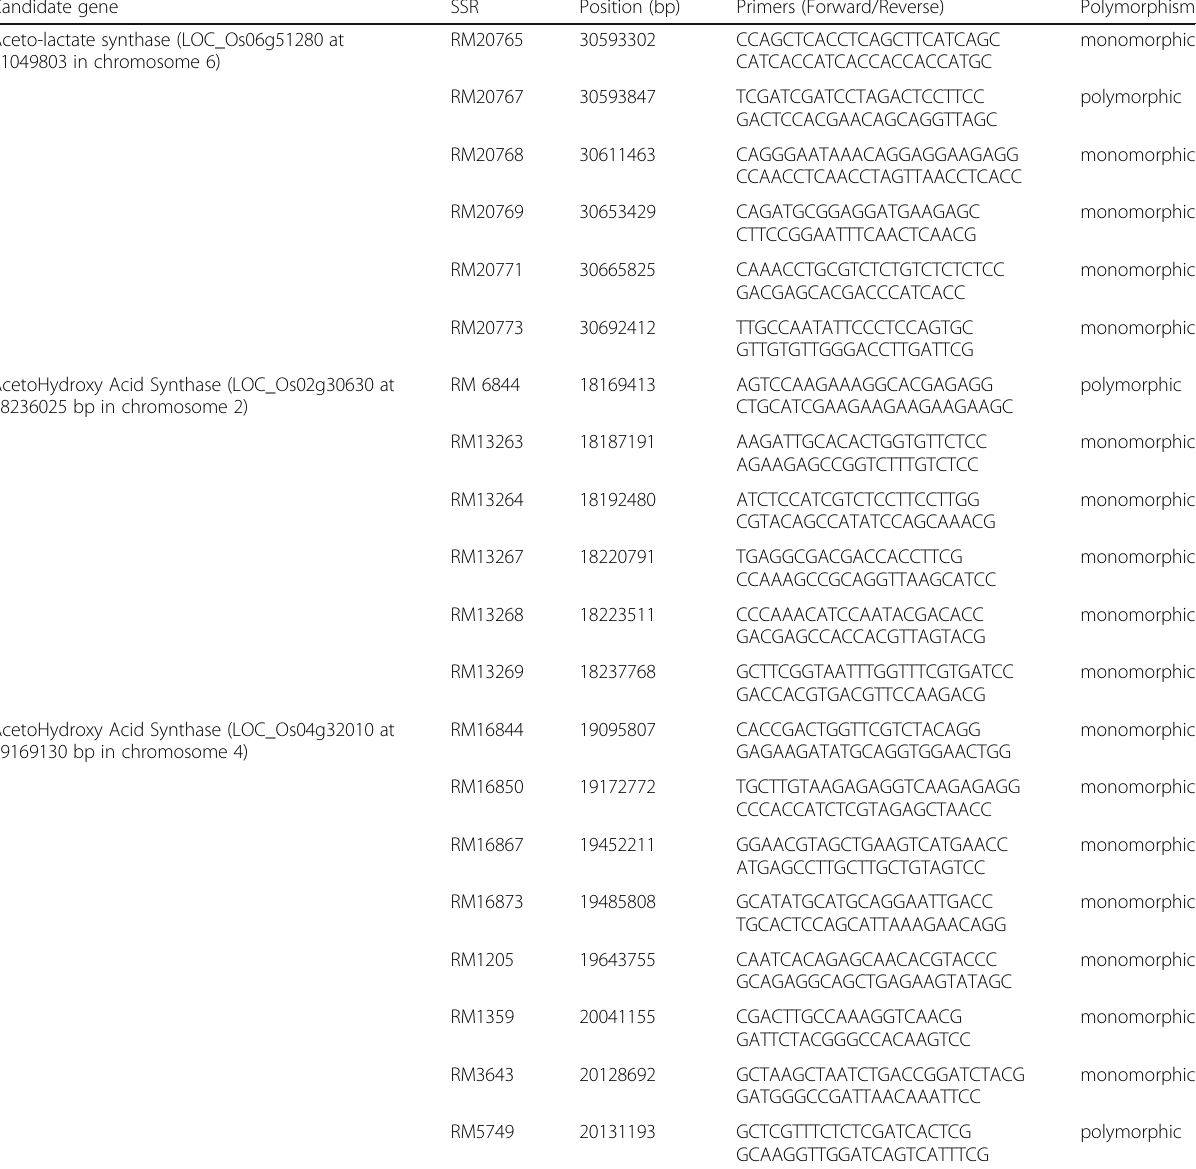
Table 2 SSR markers identified in the vicinity of candidate genes for polymorphism survey between the HTM-N22 and Pusa 1656 Candidate gene